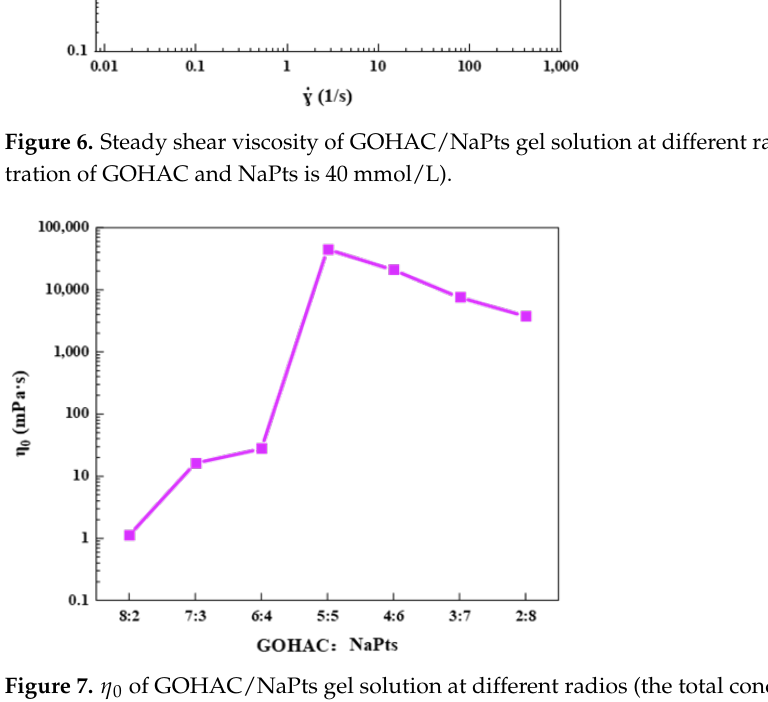
Figure 7. η 0 of GOHAC/NaPts gel solution at different radios (the total concentration of GOHAC and NaPts is 40